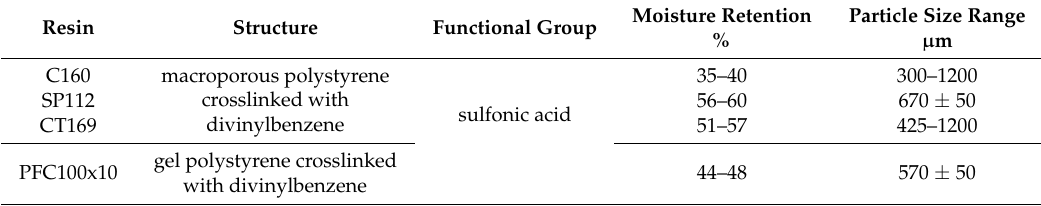
Table 1. Properties of selected strongly acidic cation-exchange